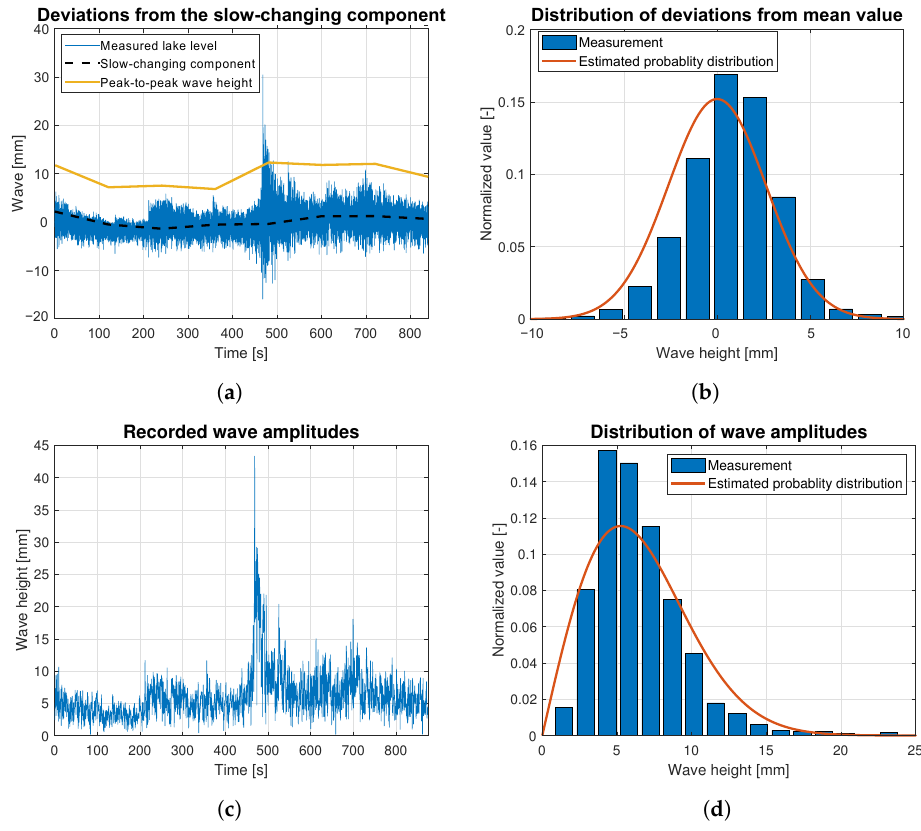
Figure 10. Statistical analysis of the wave height corresponding to 4 BFT wind force in ship scale: ( a ) deviations from the slow-changing component; ( b ) probability distribution of wave height deviations from mean value; ( c ) recorded wave amplitudes; ( d ) probability distribution of wave height